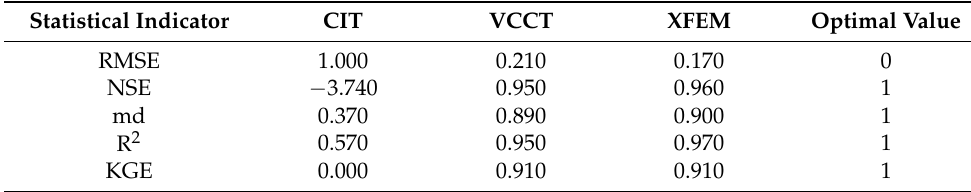
(cid:16) (cid:17) G f for different analyses versus experimental results for beam T6.